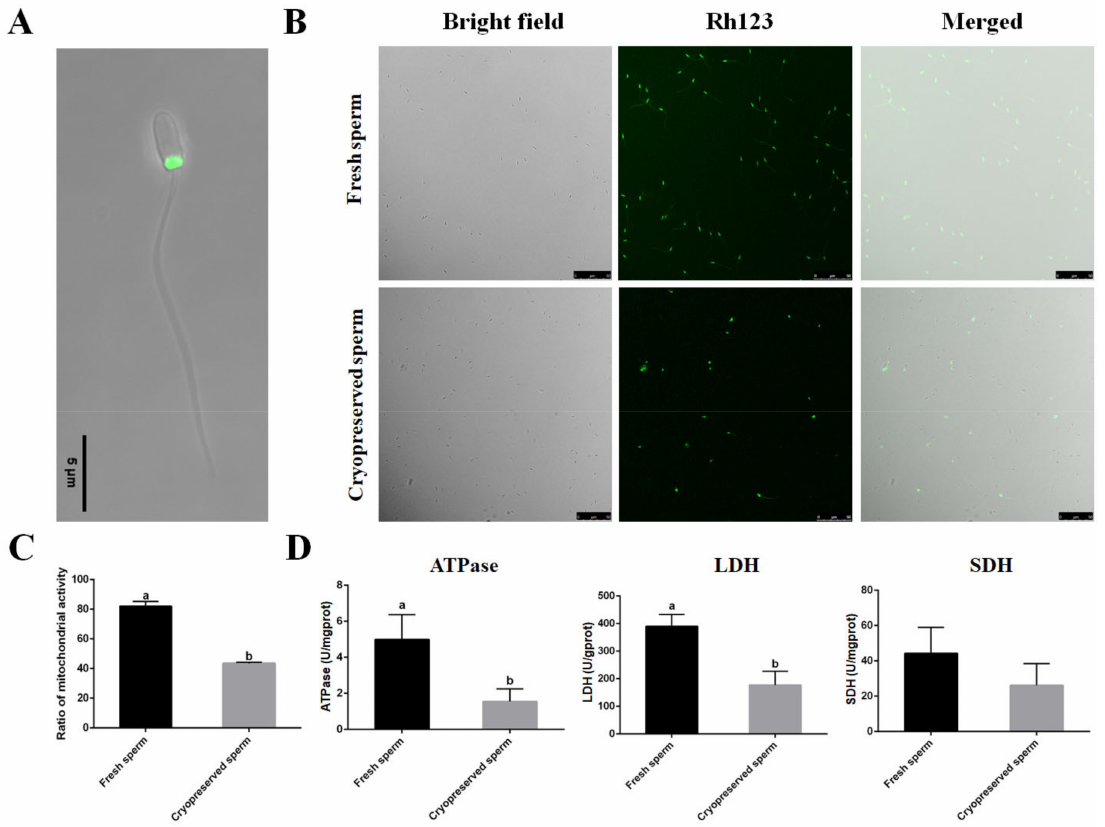
Figure 3. Effects of cryopreservation on sperm function with the cryodiluent (FBS + 15% Gly). ( A ) The location of mitochondria in black rockfish sperm. Scale bar = 5 µ m. ( B ) Detection of mitochondrial membrane potential by Rh123. Scale bar = 50 µ m. ( C ) Mitochondrial activity rate of fresh and cryopreserved sperm. Y-axis showed mitochondrial activity, measured as % of spermatozoa with green fluorescence in the mitochondrial area. ( D ) Detection of ATPase, LDH and SDH of fresh and cryopreserved sperm. Statistical significance was accepted when p < 0.05 and indicated by different